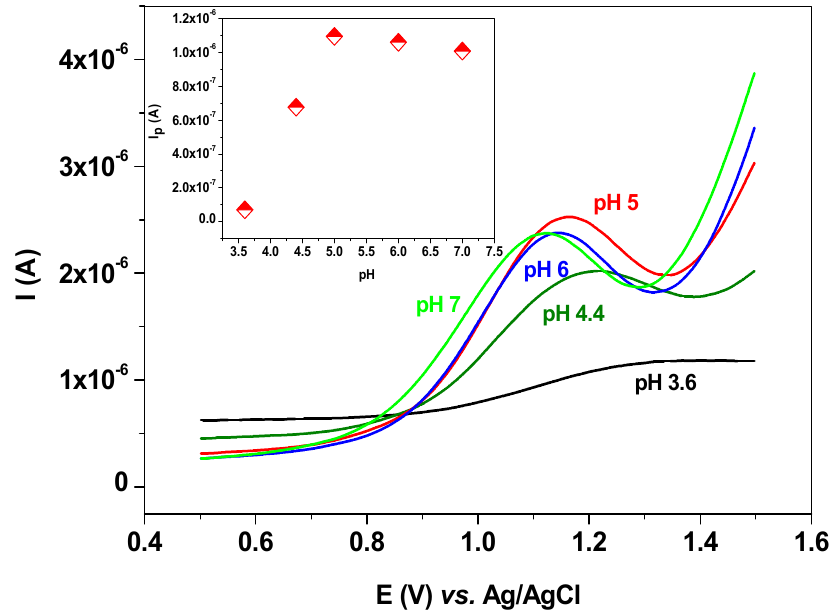
Figure 5. DPV signals recorded in supporting electrolyte of various pHs (3.6–7), each containing 10 − 5 M AZT; acetate buffer solutions (pH 3.6, 4.4, and 5) and phosphate buffer solutions (pH 6 and 7); inset: variation of peak current, I p , with the solution